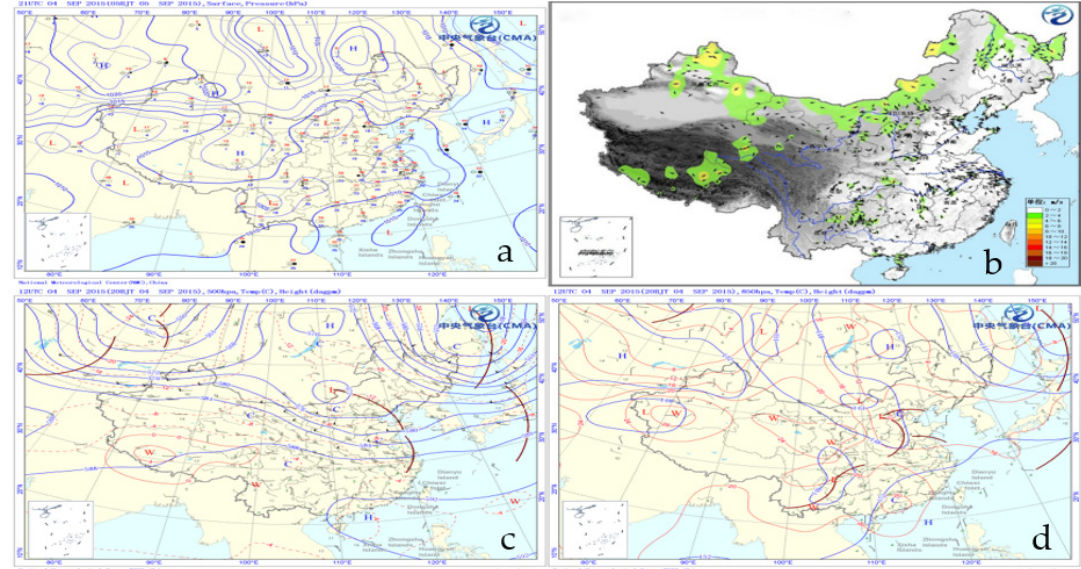
Figure 6. Maps of the weather and AQI situation at 08:00 on 4 September in 2015. Notes: ( a , c , d ) shows the map of the surface, 500 hPa height, 850 hPa height, respectively. ( b ) shows the automatic ground observation of 1 h wind field at 08:00 on 4 September in 2015.